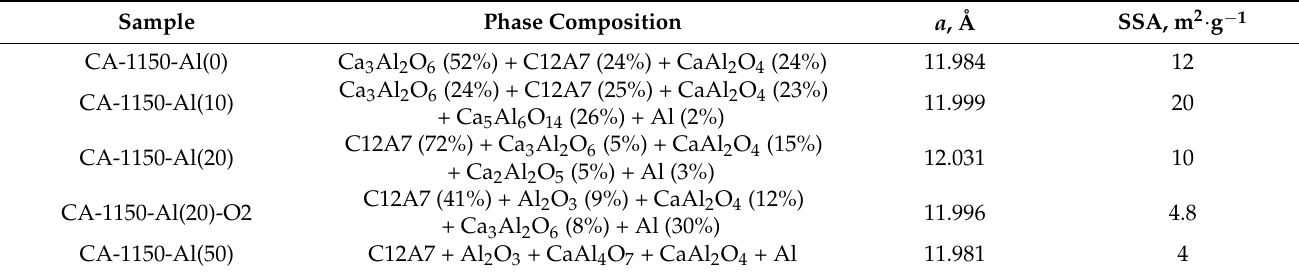
Figure 2. XRD patterns for the mayenite samples with varied content of aluminum additive after calcination in an Ar atmosphere at 1150 °C. Table 2. Lattice parameter ( a ), phase composition, and specific surface area (SSA) of the mayenite samples calcined in an Ar atmosphere at 1150 °C.